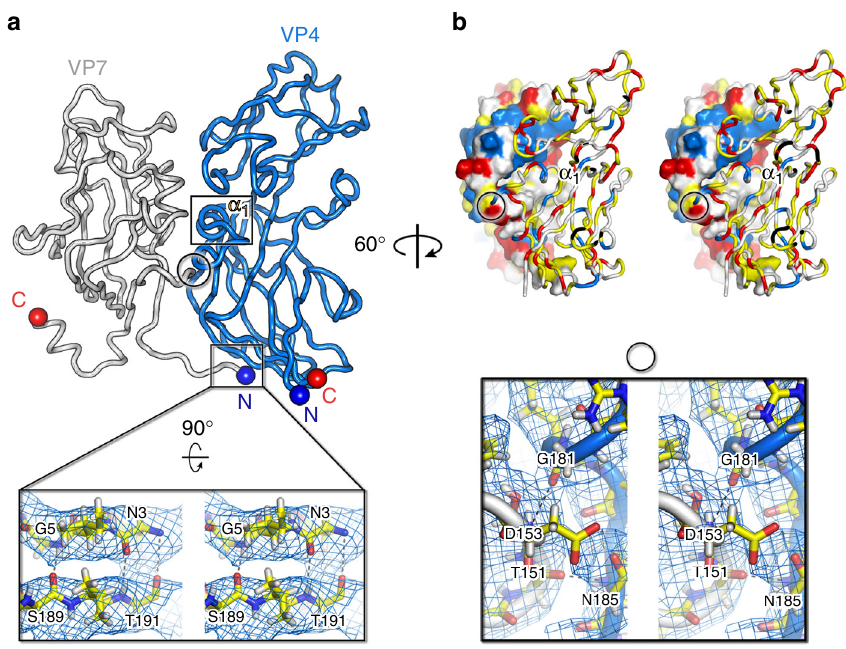
Fig. 2 VP4 – VP7 heterodimer. a Heterodimeric VP7 – VP4 building block (VP7 in light gray; VP4 marine-blue) with interacting VP7 N-terminal residues. The black-circle marks the VP7 loop, residues 149 – 154 [indicated also as dashed black circle in (Fig. 1b) left] burying underneath the region underlying the VP4 α 1 helix marked by a black rectangle, and contacting the VP4 loop, residues 181-184; blue and red spheres label the corresponding N-terminal and C- terminal. Inset, wall-eye stereoview of the main-chain hydrogen bond interactions (gray dashed lines) between the N-terminal residues of VP7 and residues of VP4 with corresponding density as blue mesh. b Top, surface and cartoon tube representation of VP7 and VP4, respectively, highlighting the charge distribution with the hydrophobic residues (A, G, V, I, L, F, M) colored in yellow, residues (R, K, H) positively charged in blue, residues (E, D) negatively charged in red and remaining polar residues in white. Bottom, wall-eye stereoview inset, suitably oriented, showing density as blue mesh and details of main-chain hydrogen bond interactions (black dashed lines) between the residues marked by the black circle in the above panels. Figure was generated in Pymol